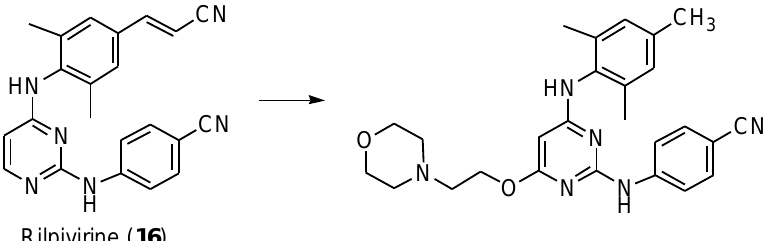
Figure 4. Functionalization of rilpivirine ( 16 ) with a polar morpholine moiety to improve its water solubility.